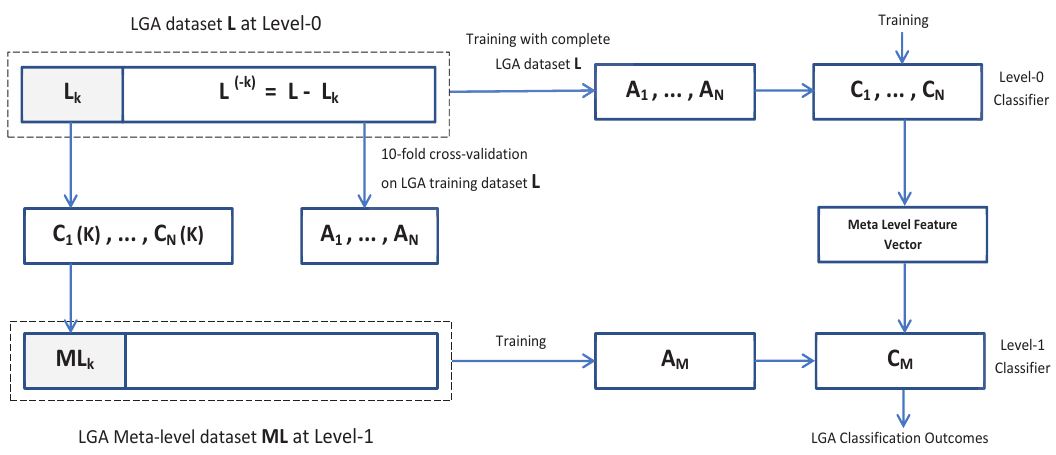
Figure 2. The establishment of K-fold cross validation process to create meta-level training data and stacking procedure with minimal generalization